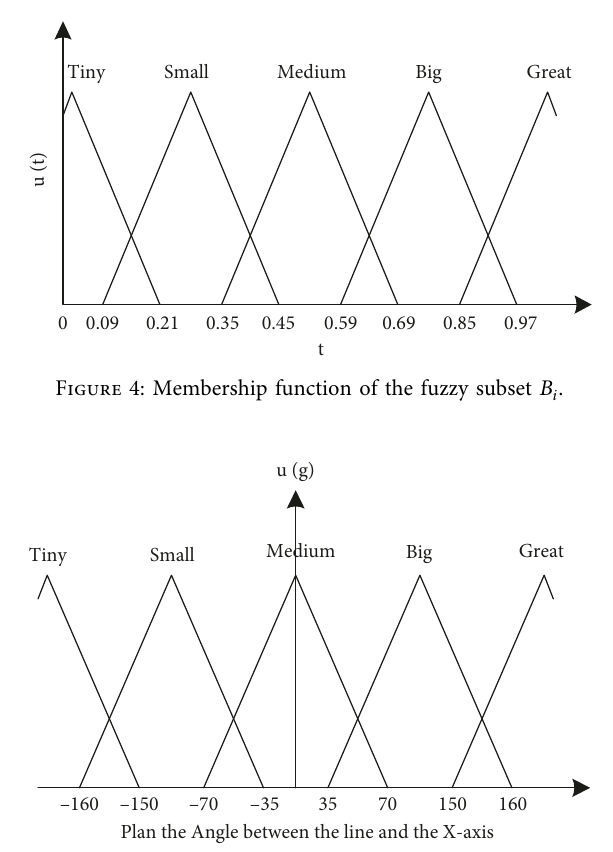
Figure 5: Membership function of the fuzzy subset C